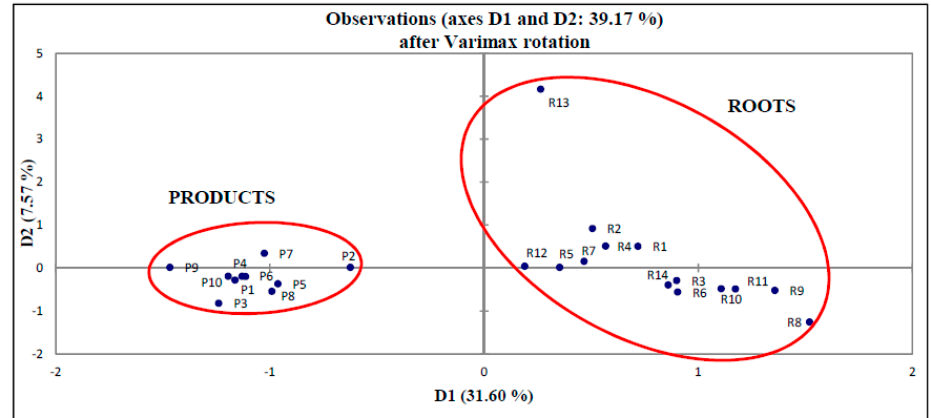
Figure 6. PCA plot of E. longifolia.